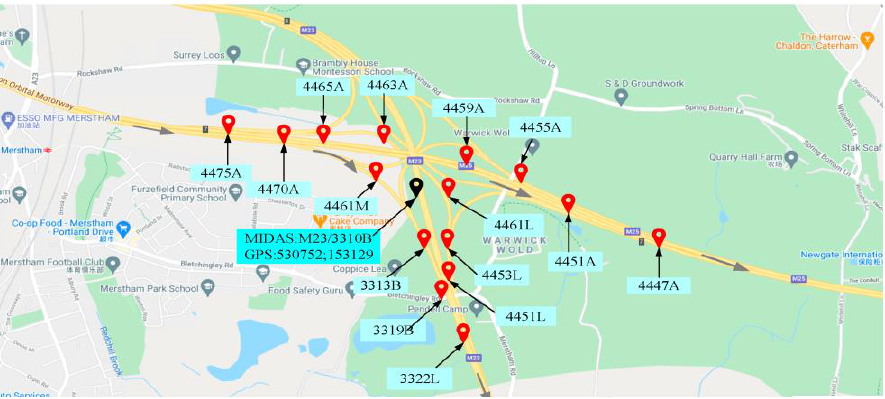
Figure 3. Distribution and ID of test points in the experimental road network.